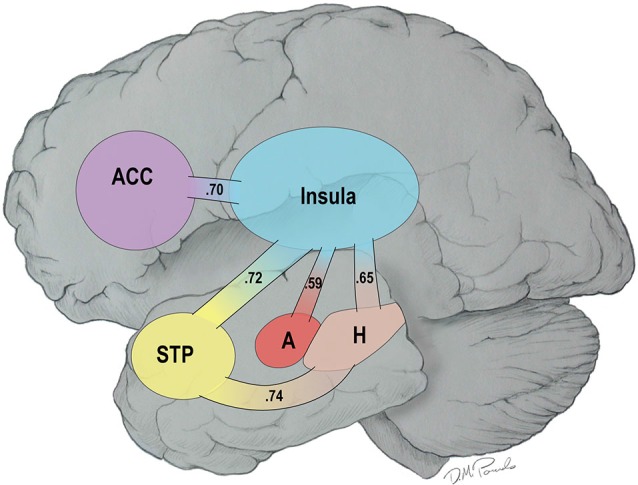
Connections among the Hubs of the Hot-State Brain Network of Appetite in a Hot- vs. a Cold-State: Values in the Paths Represent Effect Sizes for Direct Connections.